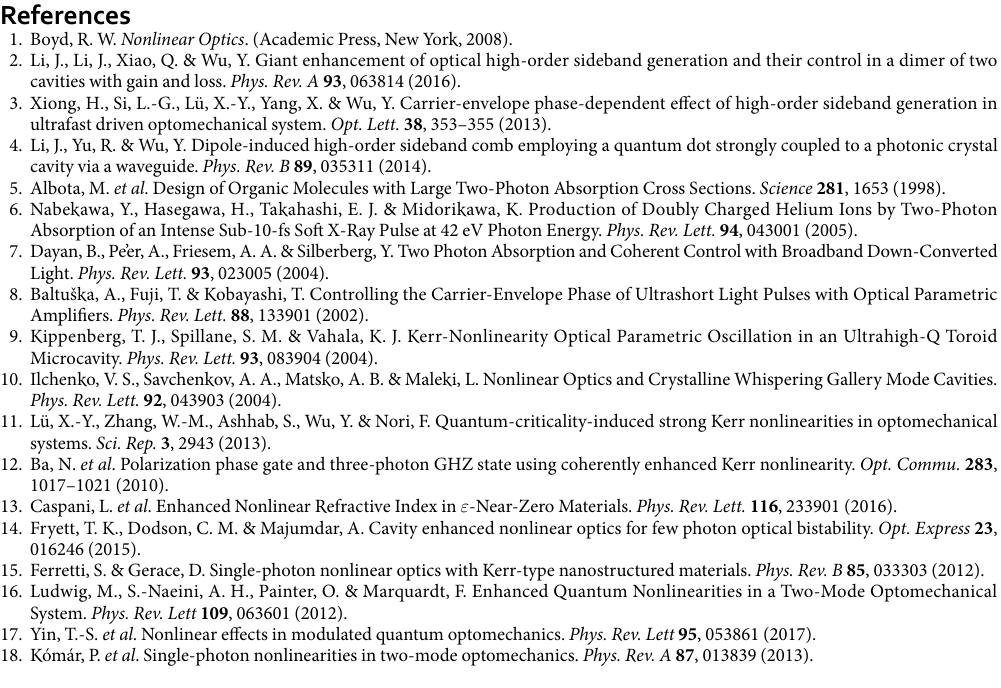
7 Scientific REPORTs | (2018) 8:2933 | DOI:10.1038/s41598-018-21137-y